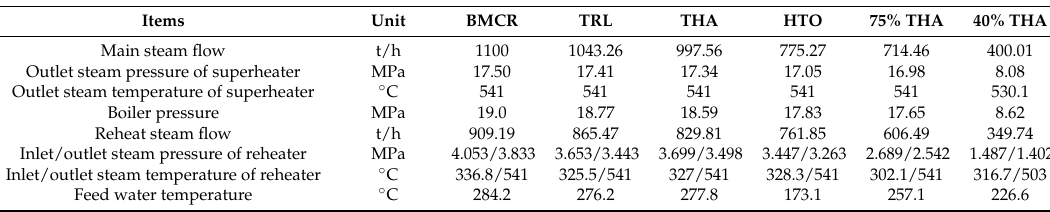
Table A1. Performance parameters of boiler (boiler maximum continuous rating (BMCR); turbine rated load (TRL); turbine heat acceptance (THA)).